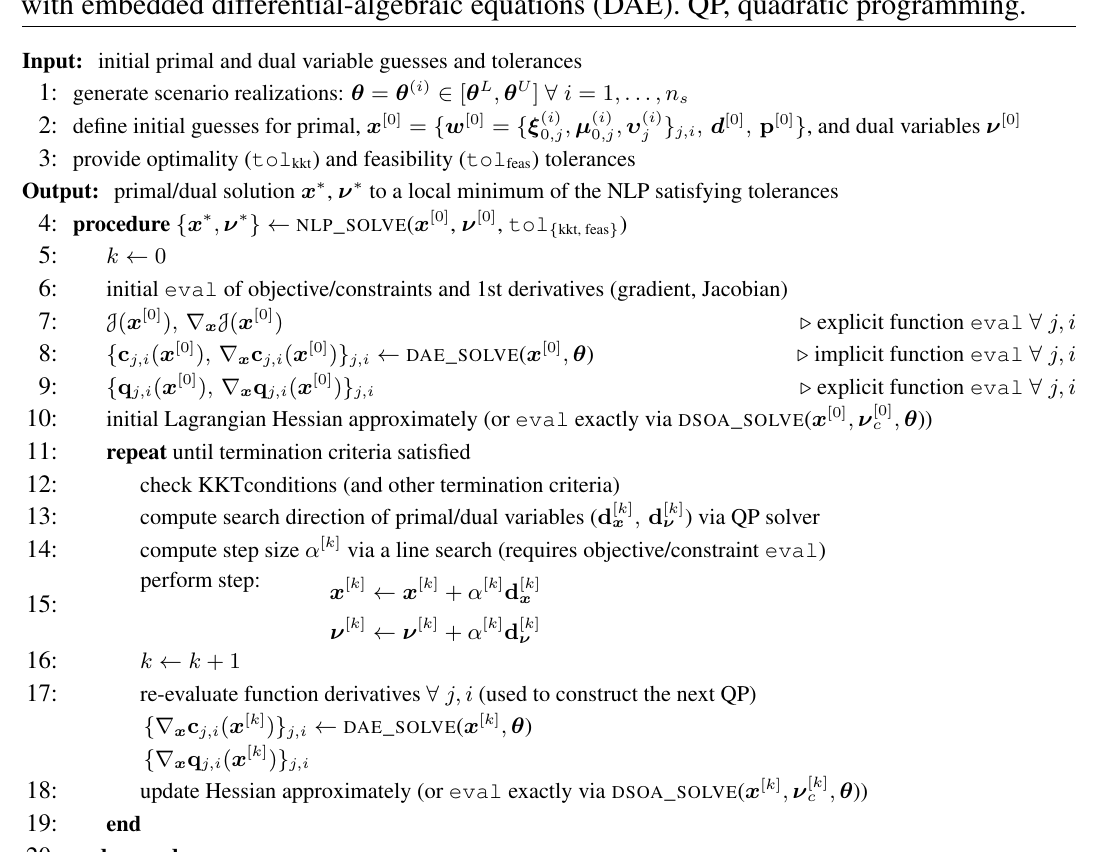
Algorithm 1 Multi-period gradient-based non-linear program (NLP) solution approach with embedded differential-algebraic equations (DAE). QP, quadratic